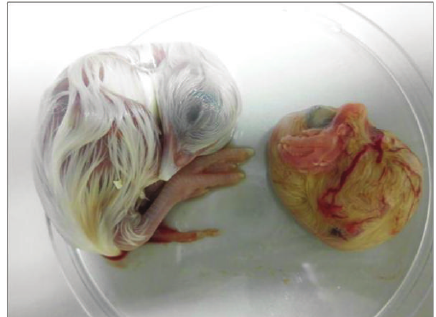
Figure 6: Chicken showing natural IBV infection. Accumulation of egg yolk in abdominal cavity (a); slightly enlarged, pale, friable liver (b) and multiple petechial haemorrhages on the serosal surfaces of proventriculus (c), gizzard (d), and small intestine (e).